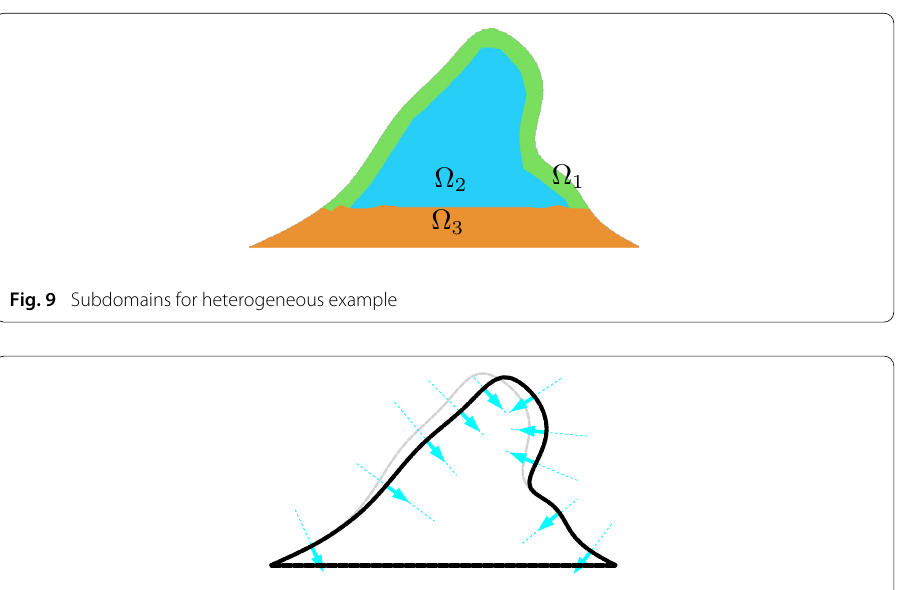
Fig. 10 Measurement points and directions as arrows indicating the positive directions for heterogeneous FSI example on the edges of the deformed geometry of the reference result (black) and initial geometry (gray)